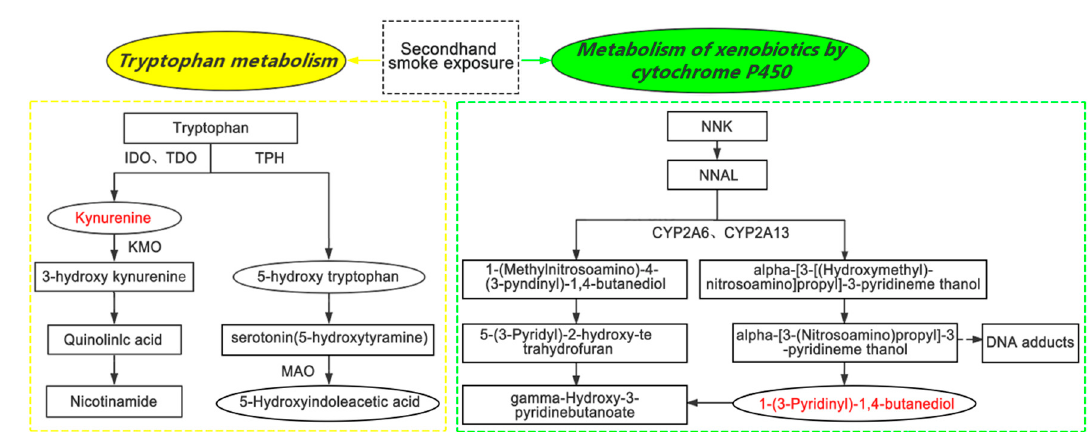
Figure 5. Simplified schematic of the relationship between exposure to SHS and metabolites following the KEGG path- way